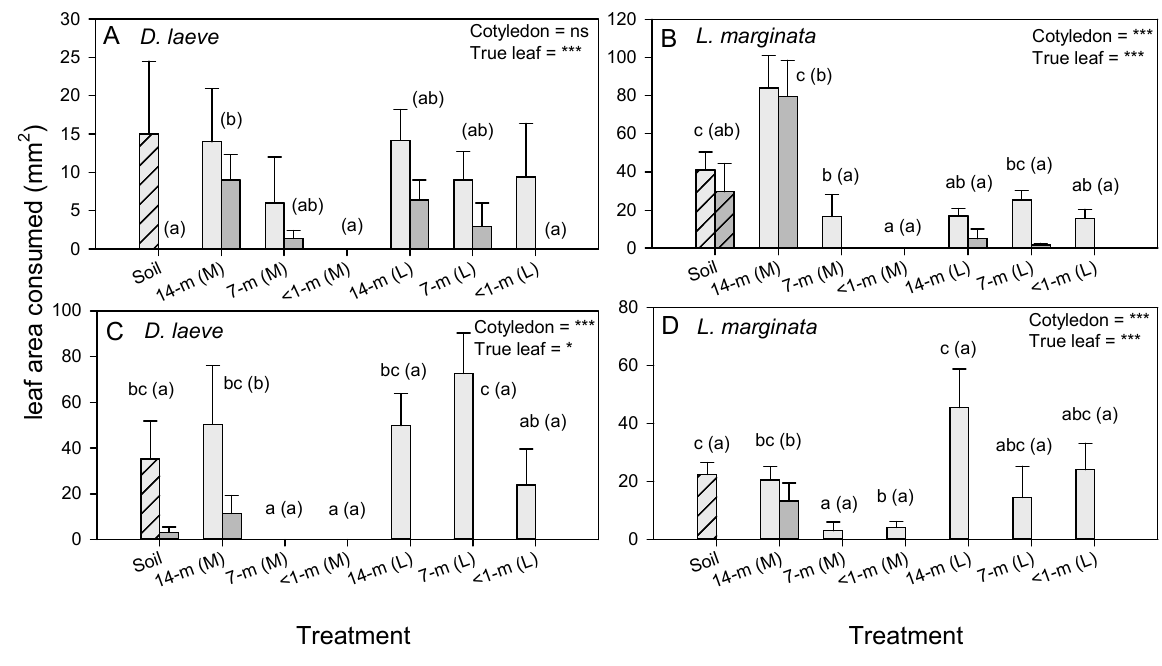
Figure 8. Results from no-choice bioassays with ( A ) D. laeve and ( B ) L. marginata on radish plants in pots, and from multichoice bioassays with ( C ) D. laeve and ( D ) L. marginata on radish plants without soil in arenas. In the no-choice bioassays, radish plants in unamended soil (hatched bars), and soil that had 14-, 7- and < 1-month-old SCG mixed (M) with soil or added as a layer (L) on top of the soil were exposed to the slugs, such that the soil and plant quality affected slug behaviors. In the multichoice bioassays, corresponding plants were exposed without soil. All plants had both cotyledon (light gray bars) and true leaves (dark gray bars) and were without soil when exposed to slugs. The results of MANOVA are presented for areas consumed from cotyledons and true leaves as ns = p > 0.05, * = p < 0.05, and *** = p < 0.001. Lowercase letters indicate homogenous treatment groups, with groupings for true leaves in parentheses. Standard errors are indicated ( A and B : N = 5; C and D : N = 6). Plants grown in each soil type as used in the bioassay are described in Figure 3.